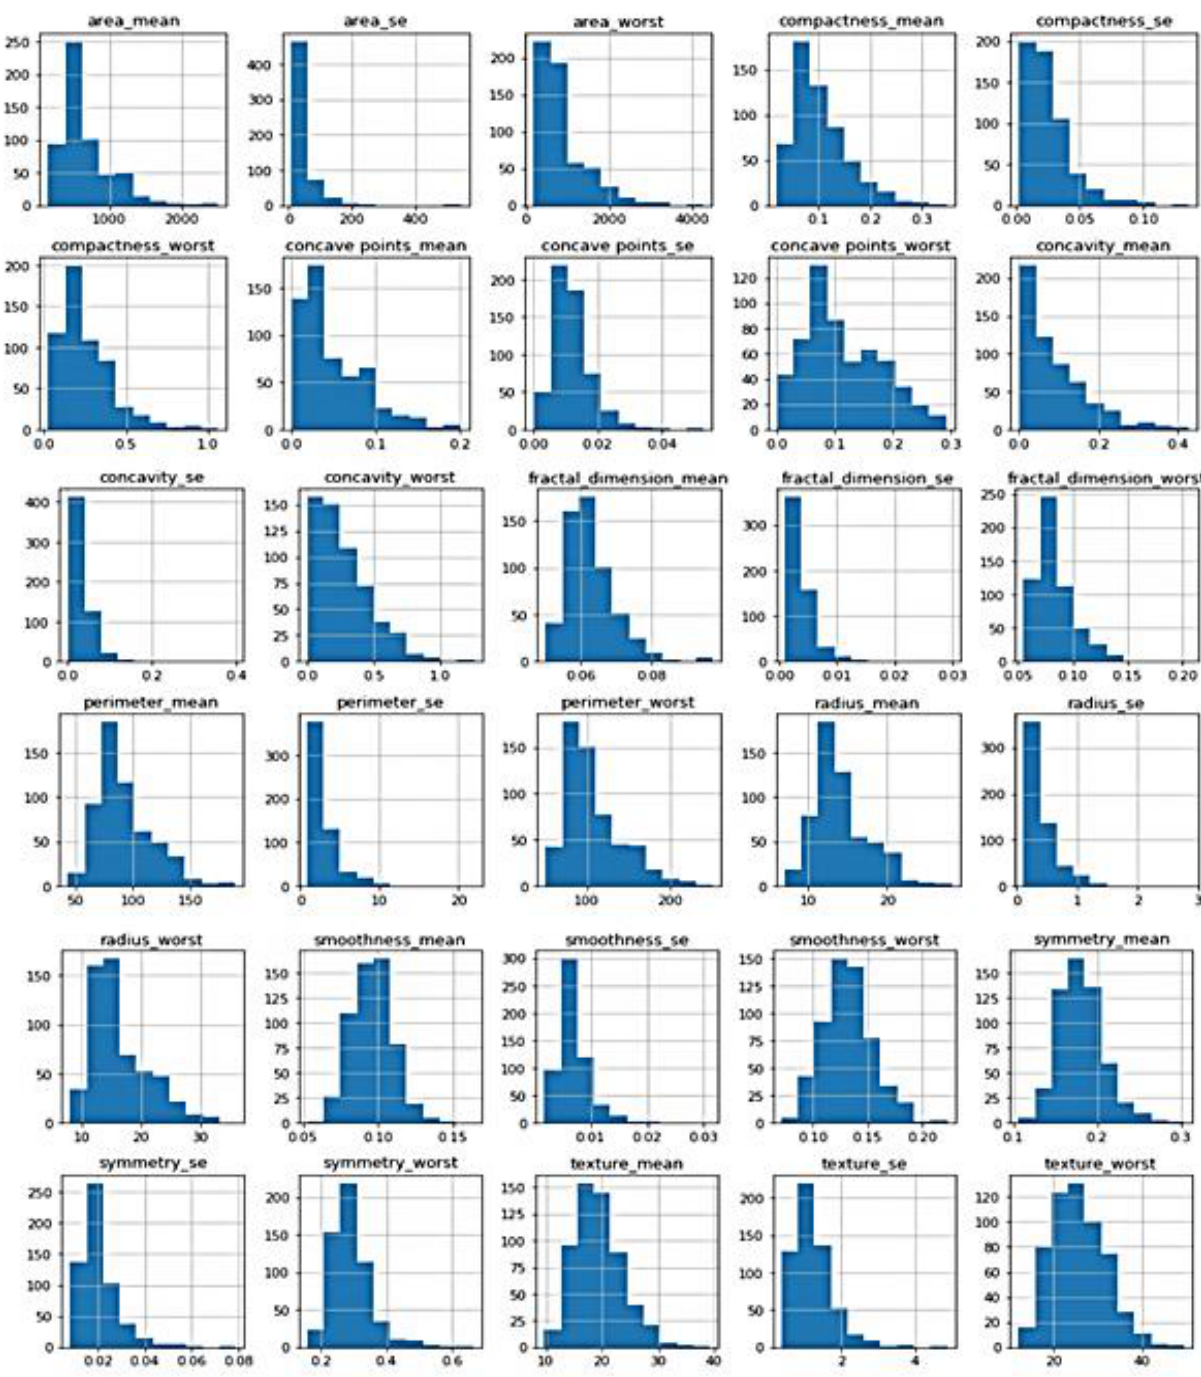
Fig. 2. Visual representation of dataset